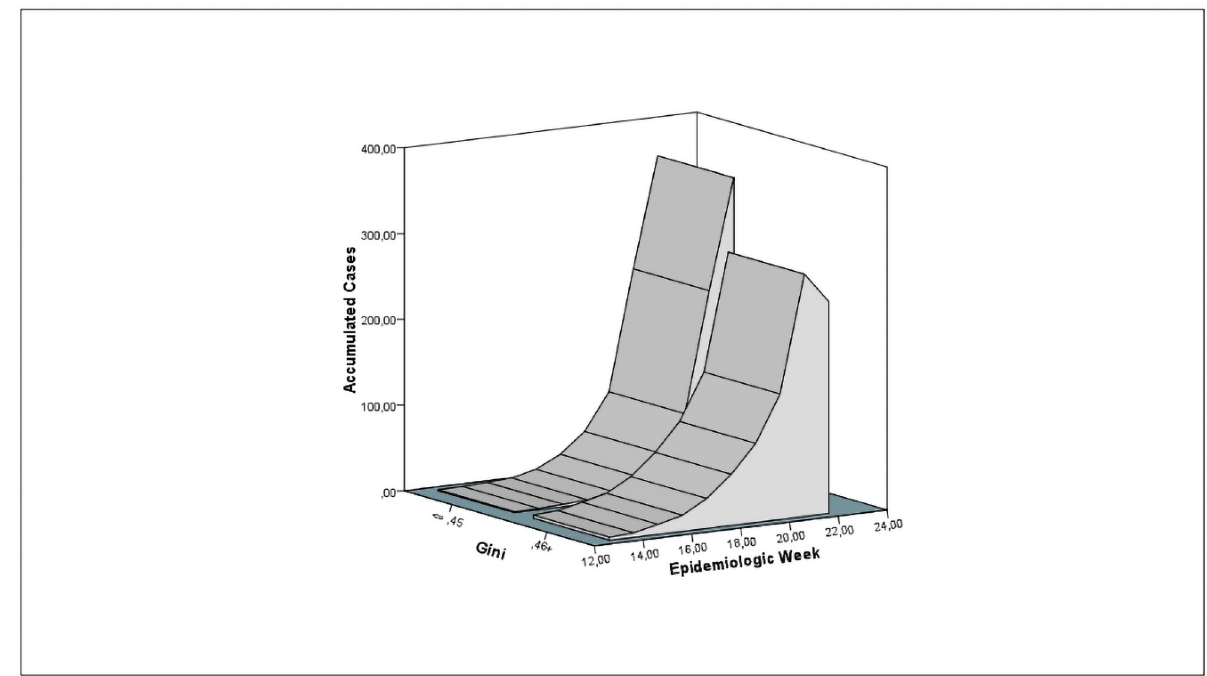
Fig 2. Temporal distribution of COVID-19 cases stratified by the Gini